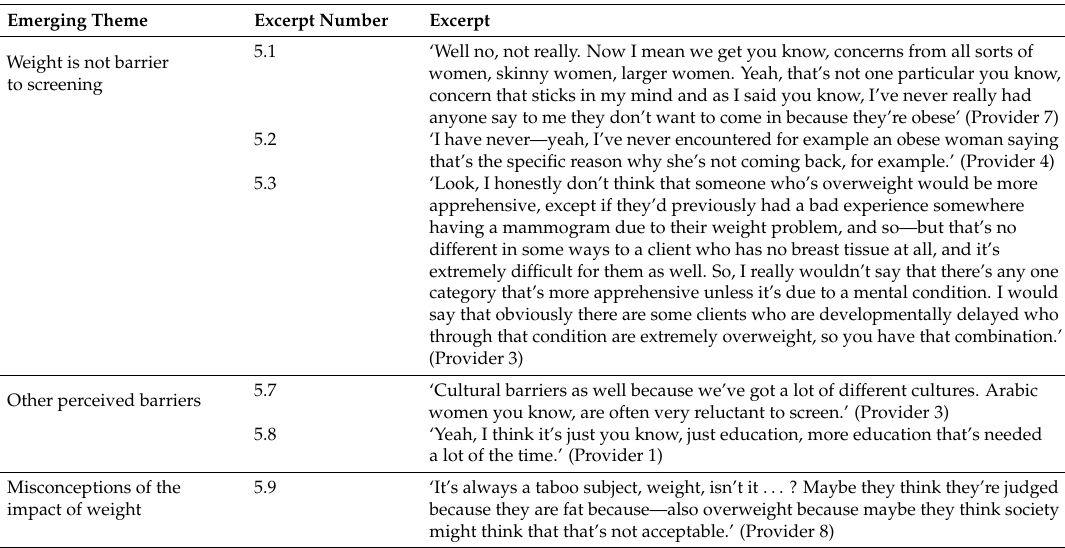
Table 7. Providers do not see obesity as a barrier to breast